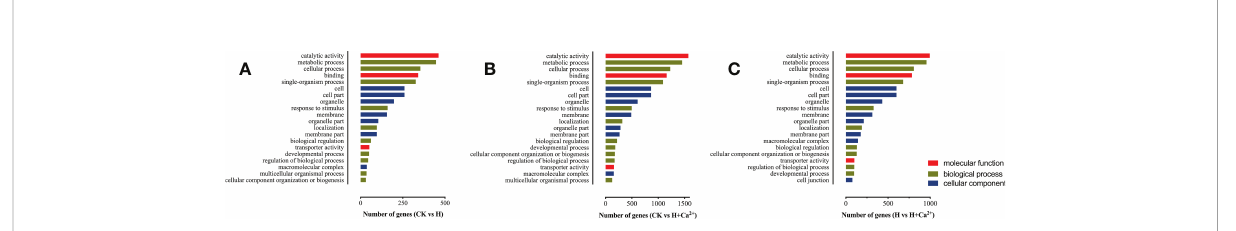
FIGURE 2 Top 20 signi fi cantly enriched GO terms of the differentially expressed genes (DEGs). (A) CK vs H (control treatment compared with hypoxic treatment), (B) : CK vs H + Ca 2+ (control treatment compared with hypoxia + CaCl 2 treatment), (C) : H vs H + Ca 2+ (hypoxic treatment compared with hypoxia + CaCl 2 treatment) Detailed information on each gene and its expression level is listed in Supplementary Table